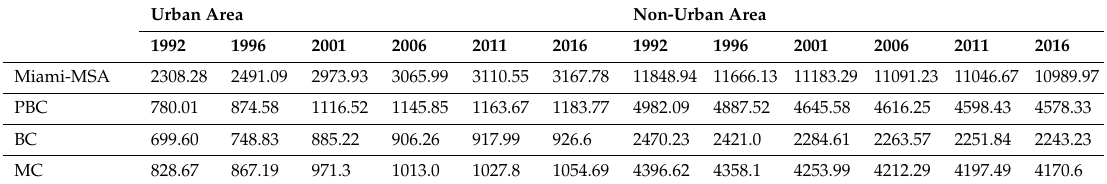
Table A1. Changes of Urban Land Covers in last 25 years (in km 2 ) in Miami MSA and three